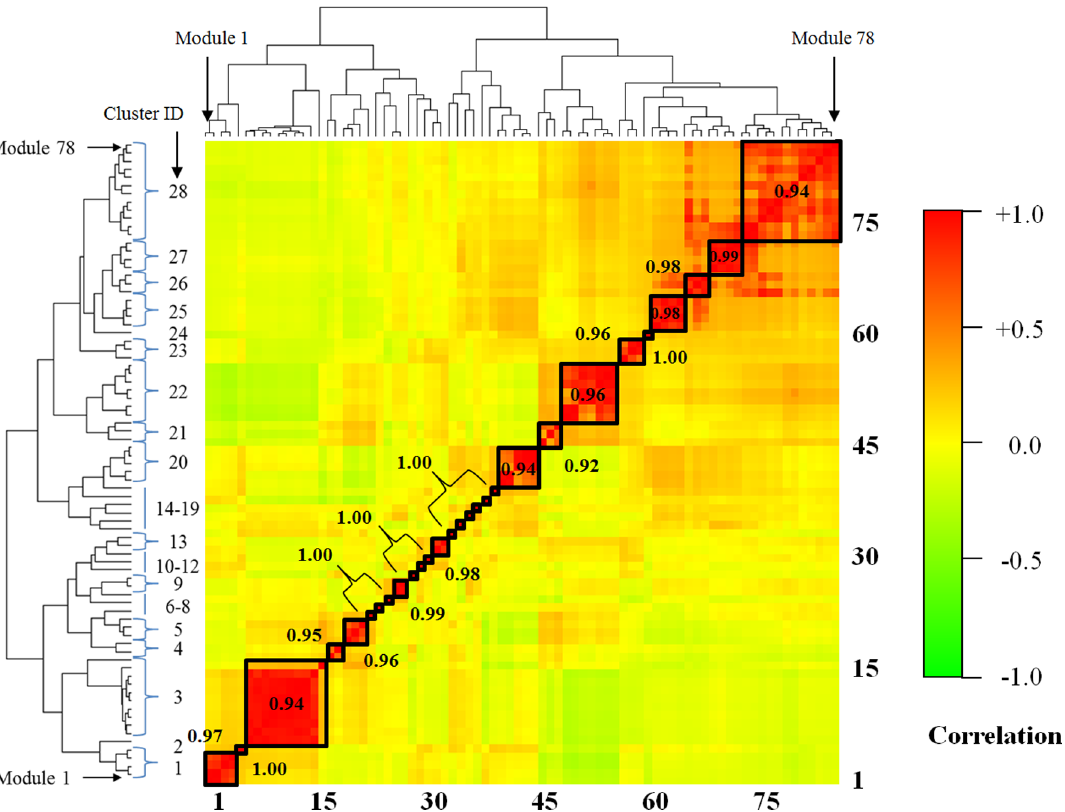
Figure 4. Clustering of the iterative signature algorithm (ISA) modules. By construction, the modules represent groups of genes co- expressed across a subset of the conditions, and they may share genes. The clustering gauges the independence of the modules and groups some modules together. A dendrogram of the clustering is shown at right, giving the module membership 1–78 of each of the 28 module clusters. The Pearson correlation is the average intra-cluster correlation between modules in the same cluster.